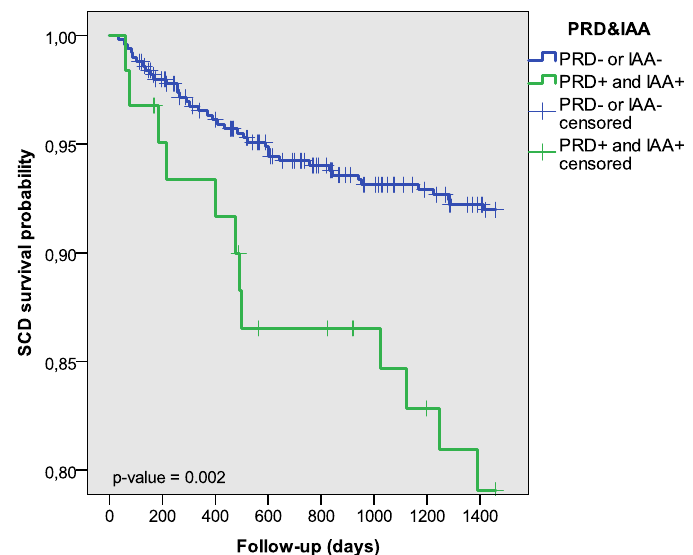
Figure 6. Estimated probability curve of SCD for two subgroups defined by PRD + and IAA + .